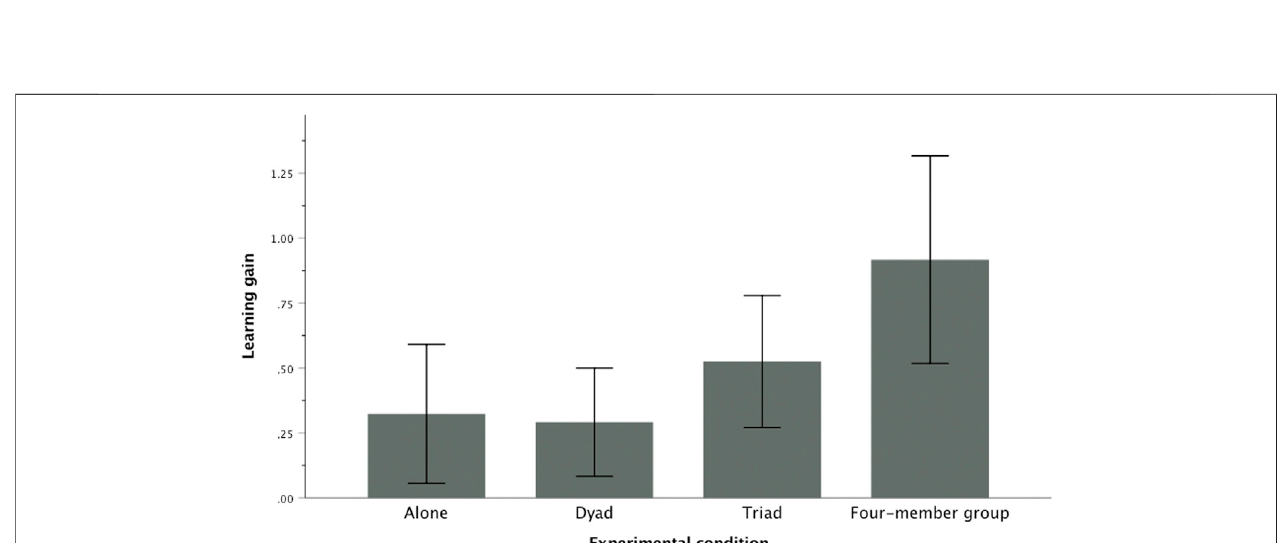
FIGURE 2 | Learning gain in each experimental